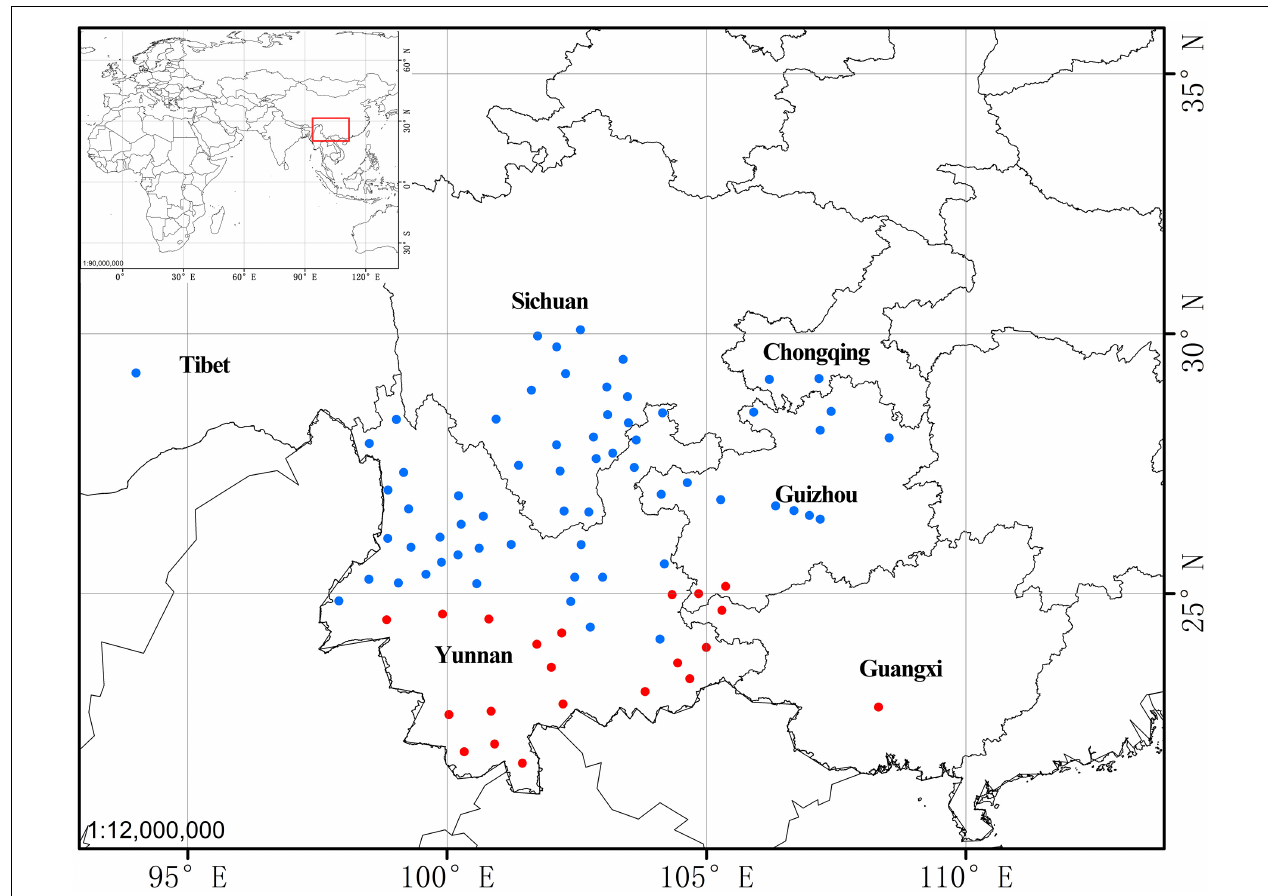
FIGURE 6 | The distribution of Paris yunnanensis s.s. (“typical” form, blue cycle) and P. liiana sp. nov. (“high stem” form, red